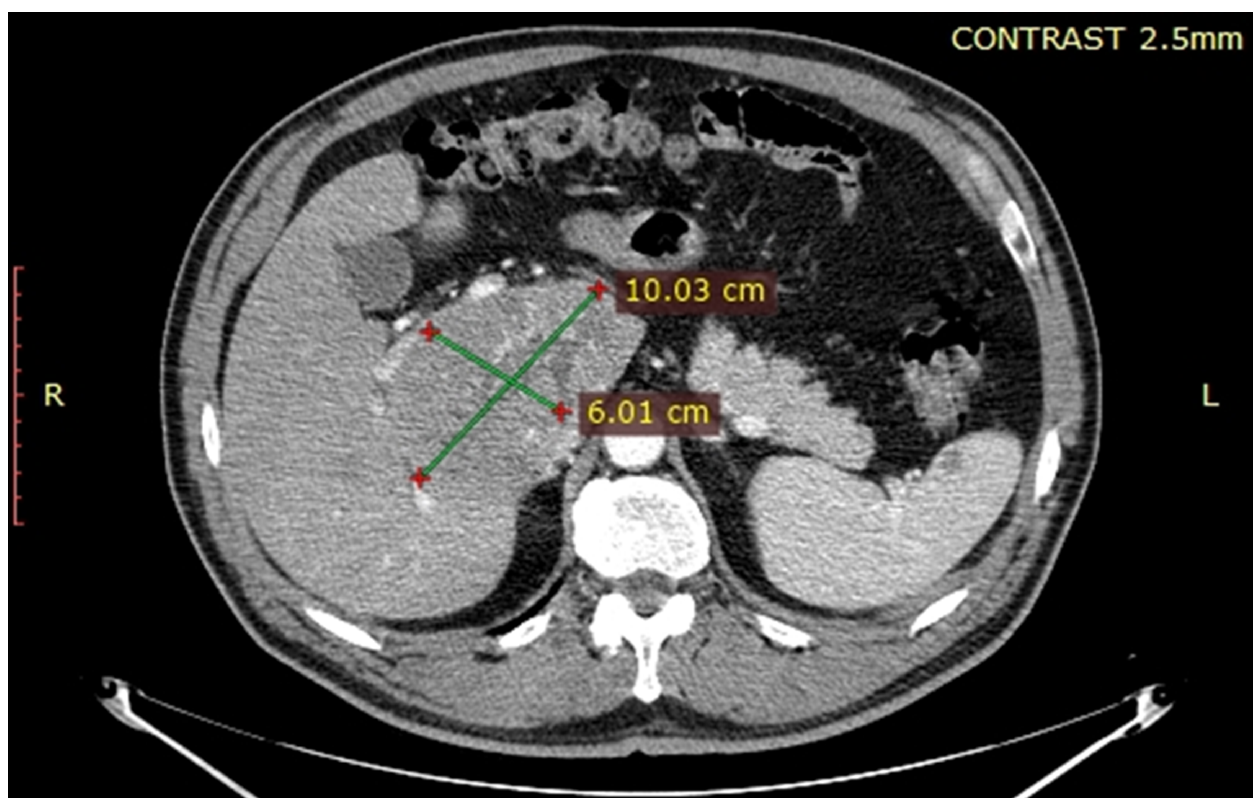
Figure 2. Computed tomography also revealed the presence of local invasion of the right hepatic pedicle.